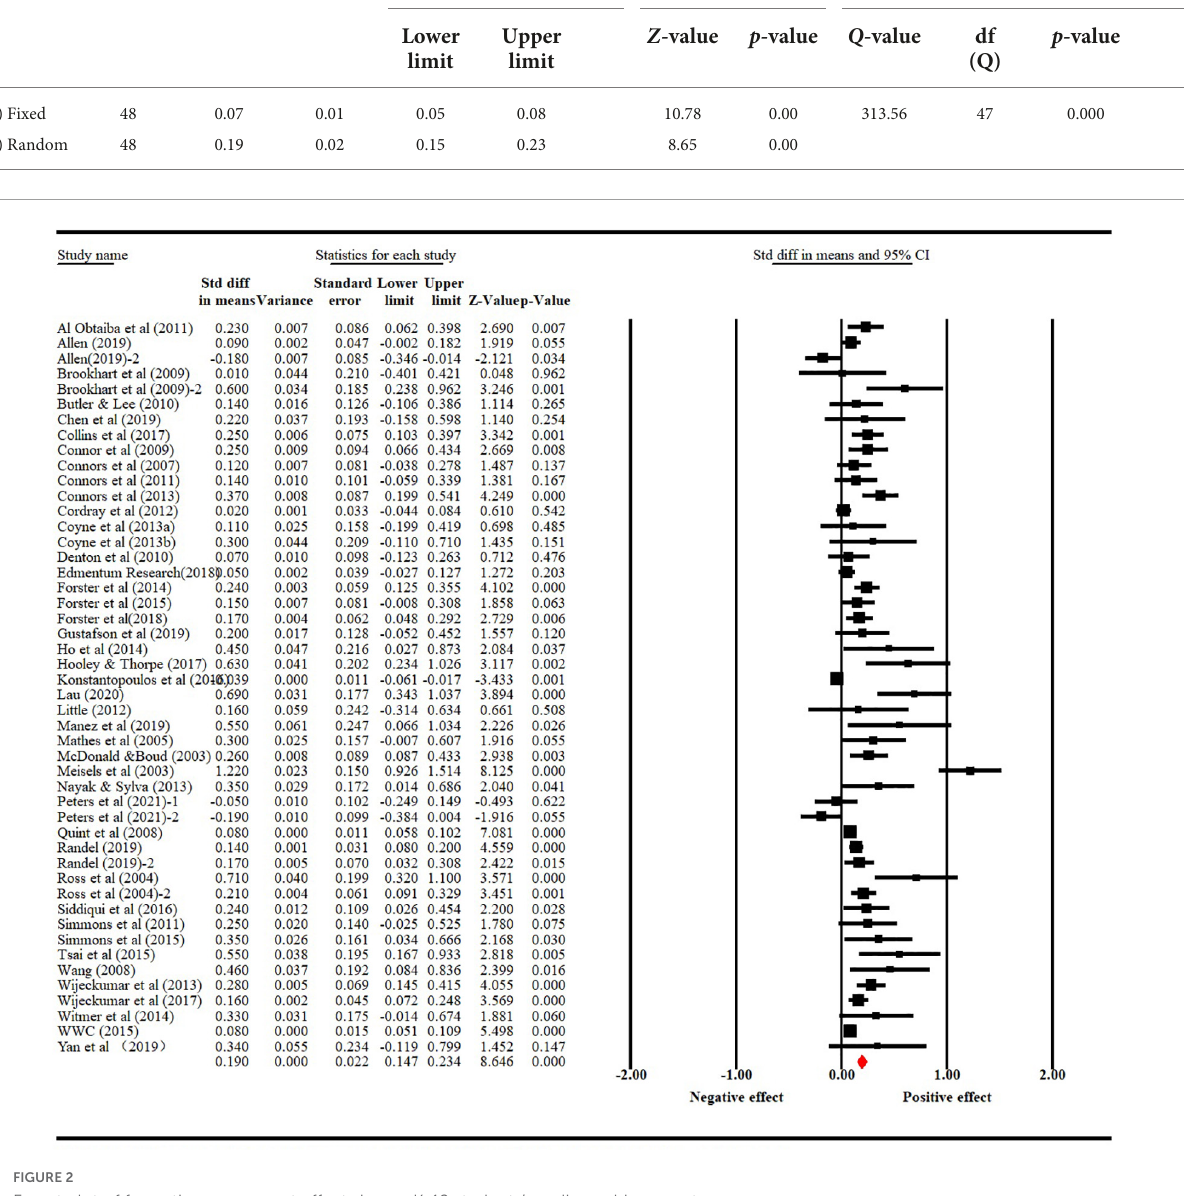
FIGURE2 Forest plot of formative assessment effect size on K-12 students’ reading